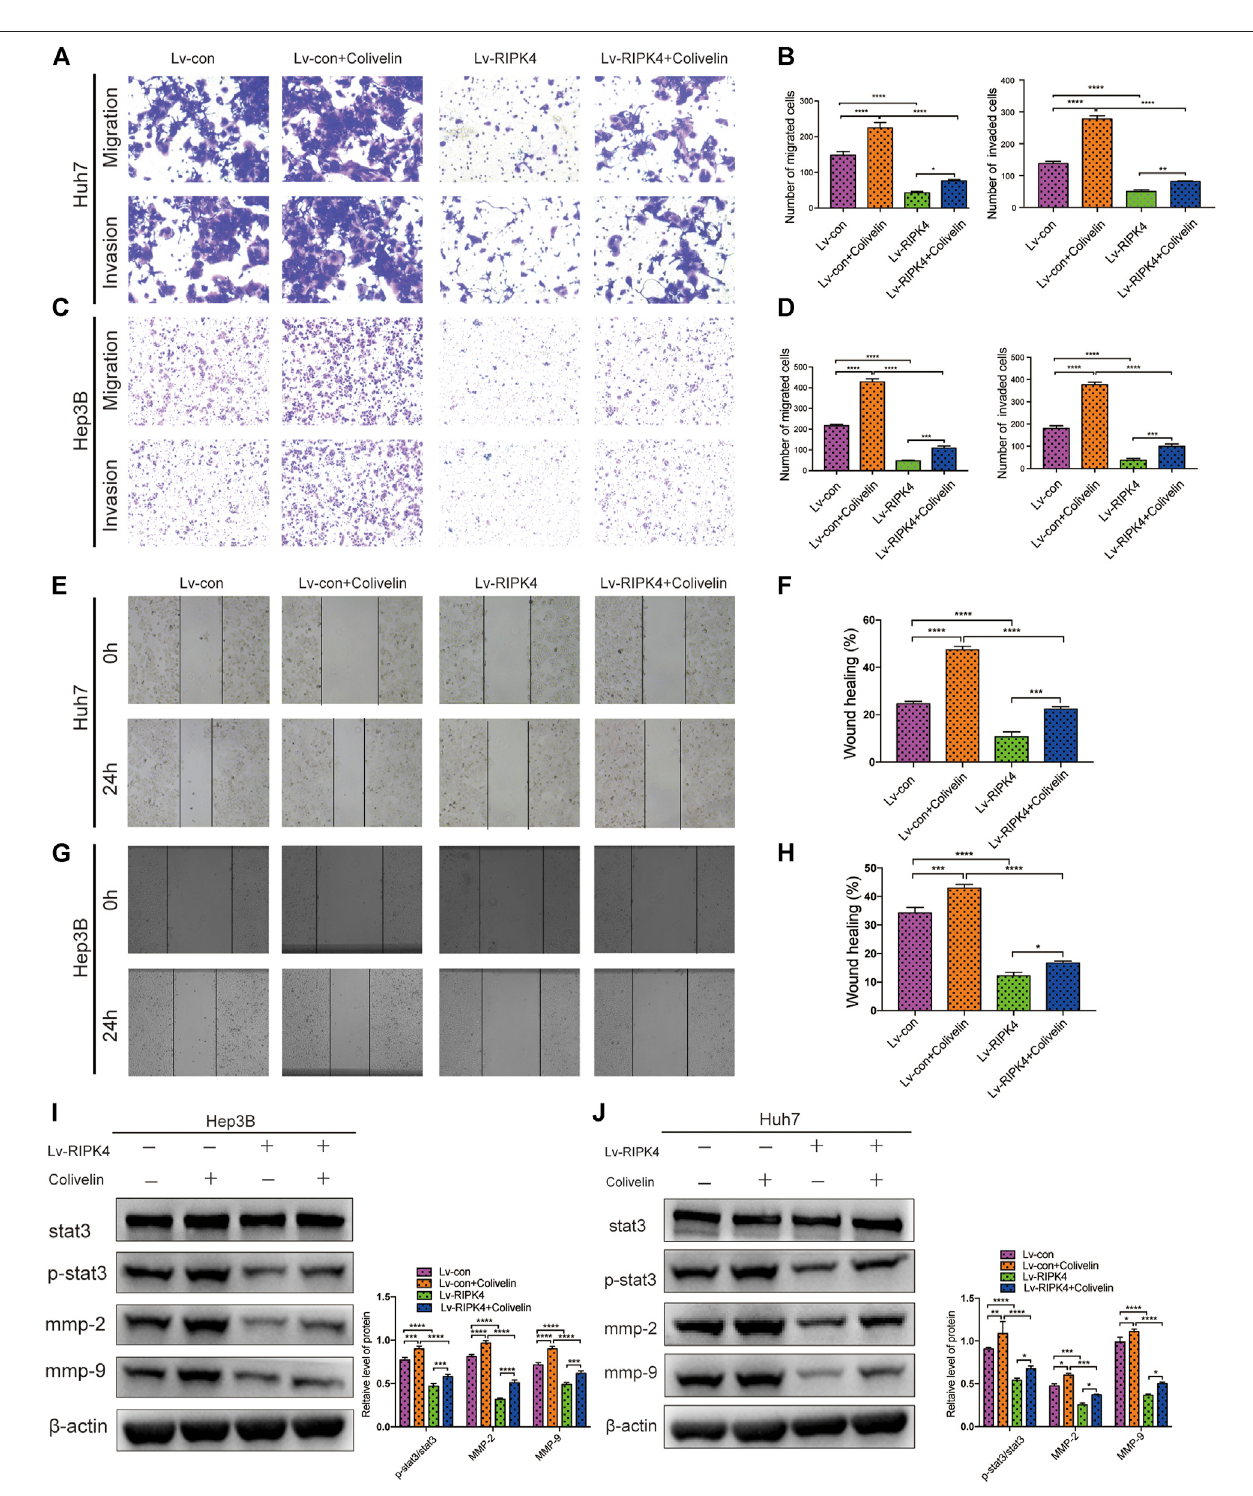
FIGURE 5 | RIPK4 inhibits the metastasis of HCC by STAT3 signaling pathway. (A,B) Comparison of Huh7 cell migration and invasion ability of each group by transwellexperiment. (C,D) ComparisonofHep3Bcellmigrationandinvasionabilityofeachgroupbytranswellexperiment. (E,F) ComparisonofHuh7cellabilityofeach group by Wound healing assay. (G,H) Comparison of Hep3B cell ability of each group using Wound healing assay. (I) Western blotting analysis of the expression of STAT3 and p-STAT3 and MMP9 and MMP2 protein. ß -actin was used asa internal control. (J) Western blotting analysis of the expression ofSTAT3 and p-STAT3 and MMP9 and MMP2 protein of Hep3B cell. ß -actin was used as a loading control. The data are expressed as mean ± SD. ** p < 0.01; *** p < 0.001.